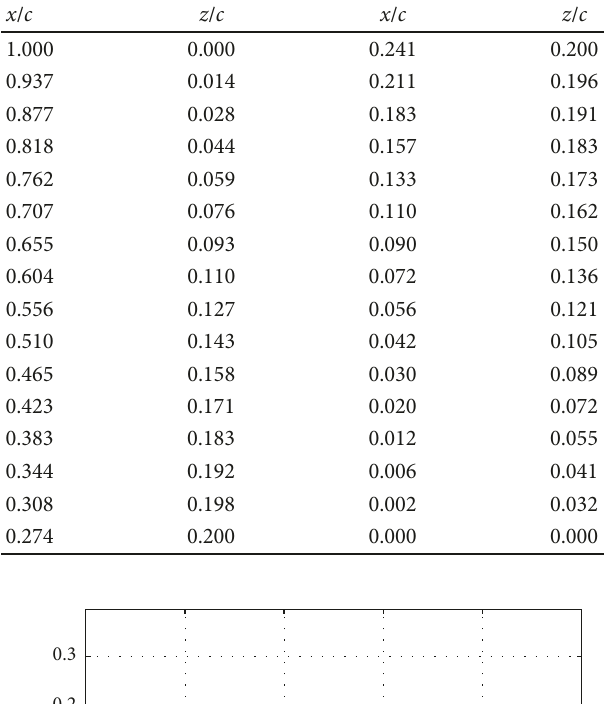
Table 1: Dimensionless pro fi le shape coordinates. “ c ” stands for the chord length. The leading edge coordinates are as follows: x / c =0, z / c =0.